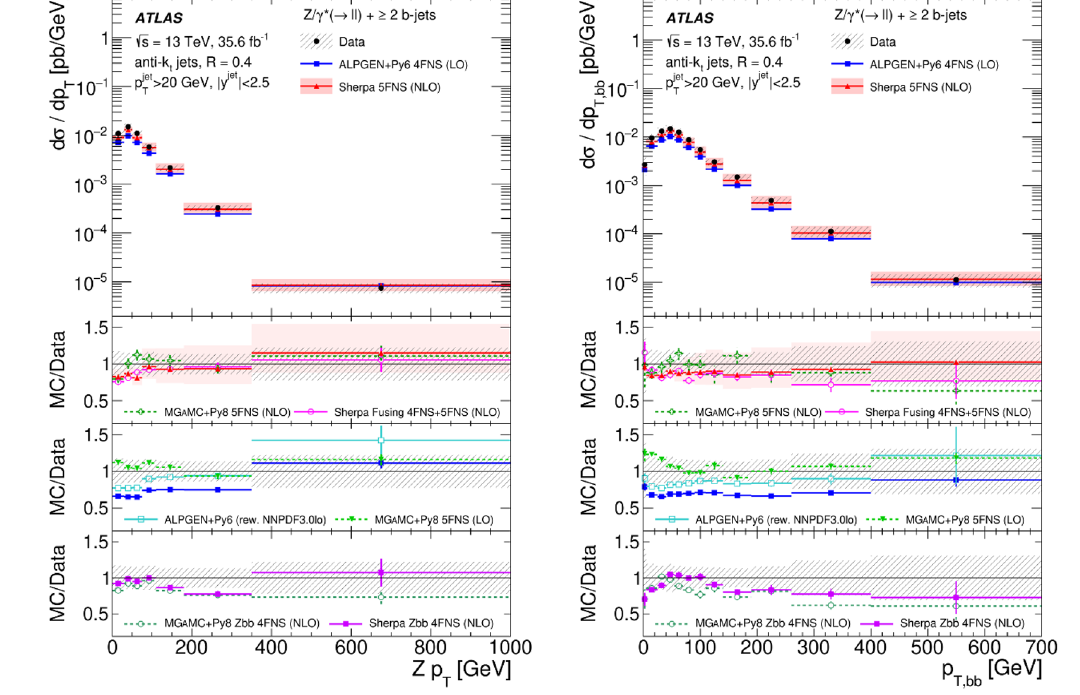
Figure 14 . Measured cross-section as a function of p T of the Z boson (left) and of the di- b -jet system ( p T ;bb ) (right) in events with at least two b -jets. The data are compared with the predictions from Sherpa 5FNS (NLO) , Alpgen + Py6 4 FNS (LO) , Sherpa Fusing 4FNS+5FNS (NLO) , Sherpa Zbb 4FNS (NLO) , MGaMC + Py8 5FNS (LO) , MGaMC + Py8 Zbb 4FNS (NLO) and MGaMC + Py8 5FNS (NLO) . The error bars correspond to the statistical uncertainty, and the hatched bands to the data statistical and systematic uncertainties added in quadrature. The red band corresponds to the statistical and theoretical uncertainties of Sherpa 5FNS (NLO) added in quadrature. Only statistical uncertainties are shown for the other